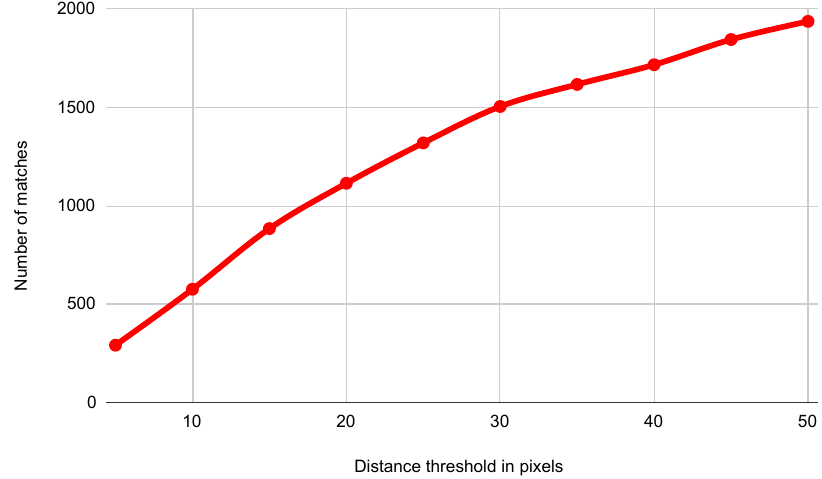
Figure 8. Amount of DeepMatching features obtained with different levels of filtering. The more we increase the distance threshold, the more matches we get, but also, the more error we are allowing in the